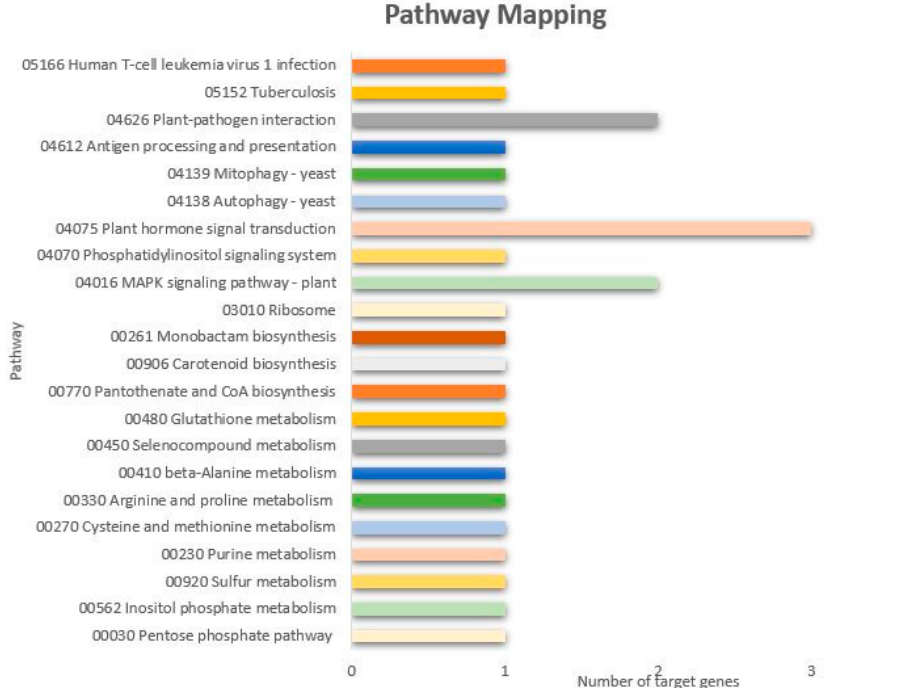
Figure 8. KEGG pathways mapped using the KAAS tool among the predicted targets of the identified miRNAs in guava.